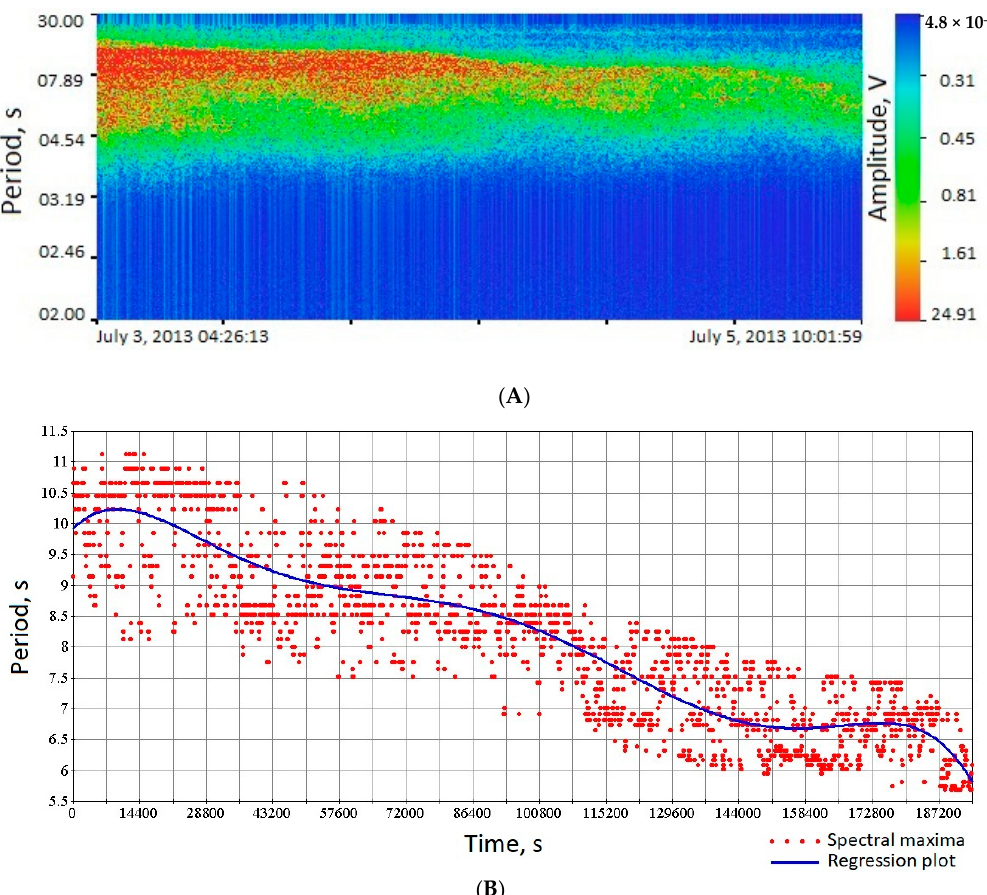
Figure 2. ( A ) Swell wave spectrogram recorded by a laser meter of hydrosphere pressure variations in the period from 3 July to 5 July, 2013 and ( B ) regression plot, constructed on the spectral maxima singled out from the signal spectrogram recorded in the period from 3 July to 5 July, 2013.